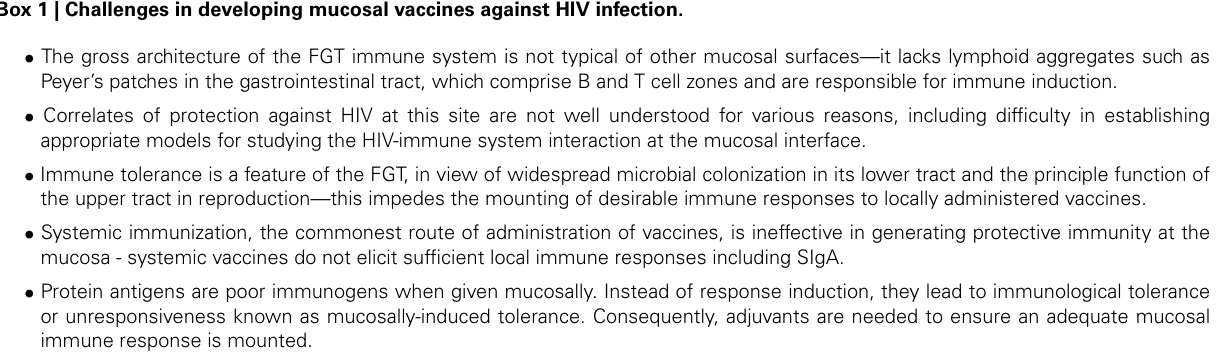
Box 1 | Challenges in developing mucosal vaccines against HIV